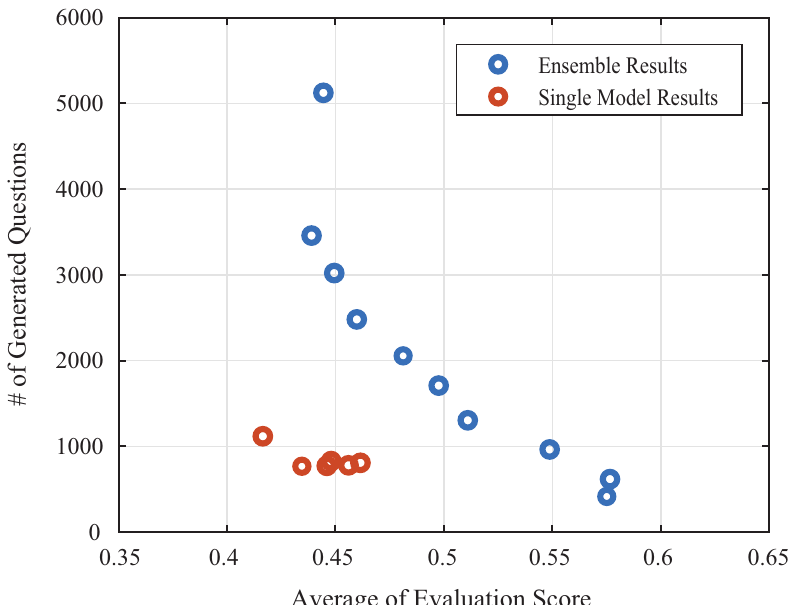
Figure 4. Comparison results of question